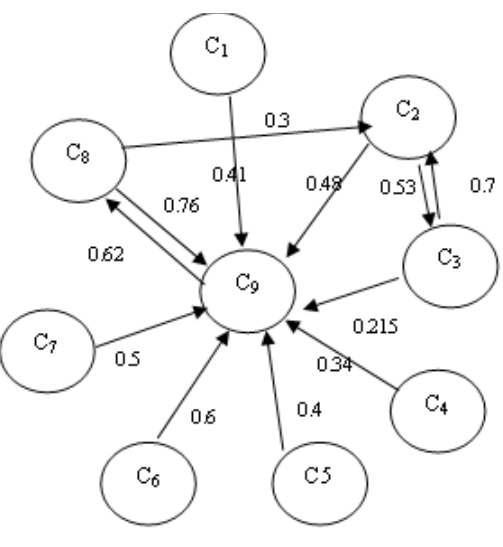
Figure 1. Fuzzy Cognitive Map for Oral Tumor